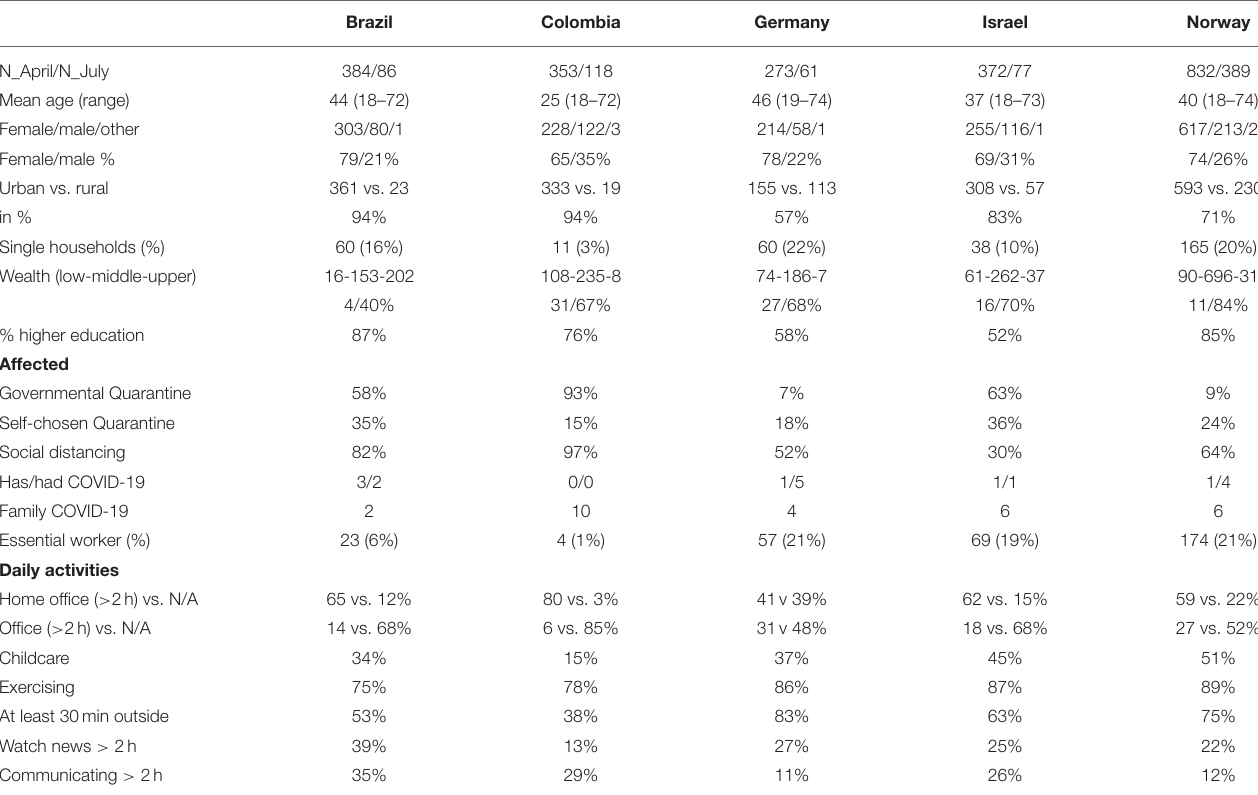
TABLE 1 | Sample demographics, affection and selected daily activities in